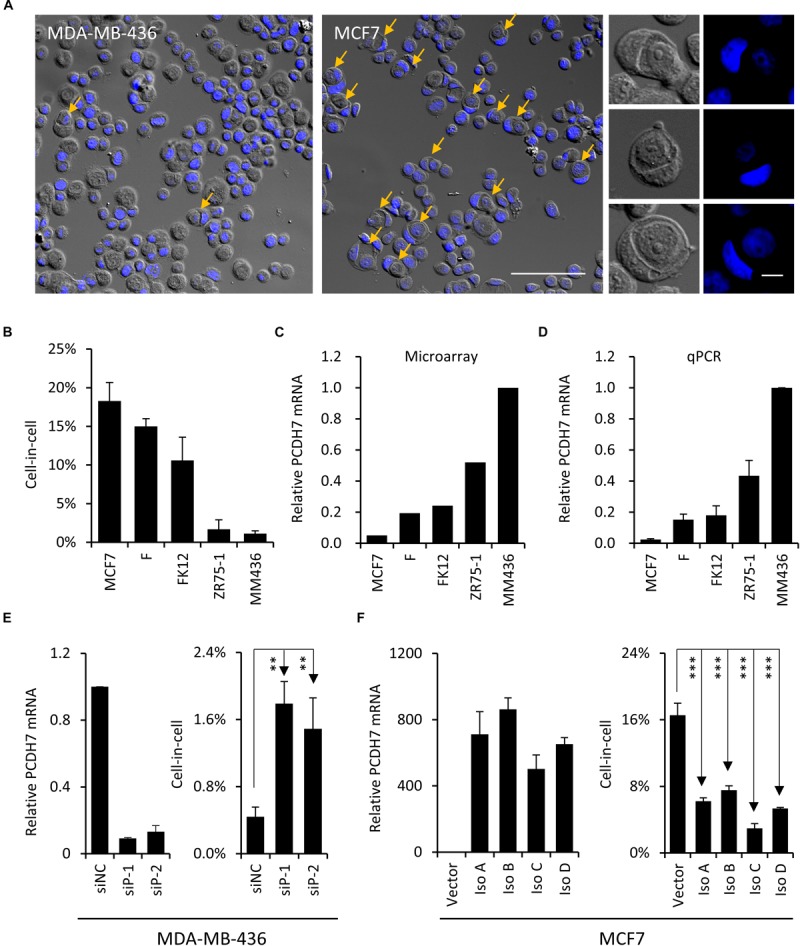
PCDH7 inhibits homotypic cell-in-cell formation. (A) Representative cytospin images for MCF7 and MDA-MB-436 cells. Representative images for typical CIC structures of different stages are shown in right. Yellow arrows indicate hoCIC. The nuclei were stained with DAPI (blue). Scale bar: 100 μm (left) and 10 μm (right). (B) The frequencies of hoCICs formation in different breast tumor cell lines. Data are mean ± SD of triplicate experiments. (C,D)
PCDH7 expression in microarray (C) and determined by quantitative RT-PCR (D). Data are mean ± SD of triplicate experiments. (E)
PCDH7 knock-down (left) results in increased CIC formation (right) in MDA-MB-436 cells. Data are mean ± SD of triplicate experiments. ∗∗P < 0.01. (F) Overexpression of PCDH7 isoforms (left) inhibits CIC formation (right) in MCF7 cells. Data are mean ± SD of triplicate experiments. ∗∗∗P < 0.001.